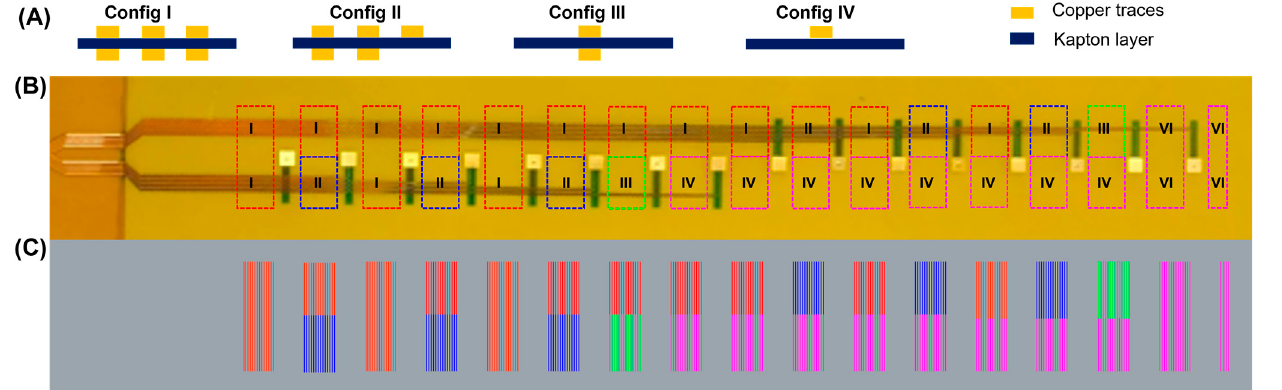
Figure 3. Schematic of various zones for dual-layer flex-PCB. ( A ) Schematics of four possible flex-PCB configurations: (I) multiple serpentines on both the top and bottom layers, (II) multiple serpentines on both top and bottom layers, plus a single layer serpentine on either layer, (III) single serpentine on both the top and bottom layers, and (VI) single serpentine on both either the top or bottom layer. ( B ) Image of dual-layer flex-PCB. ( C ) Image of laser cutting path with color-coded zones. Laser power values: (I) Red 11%, (II) Blue 8%, (III) Green 10%, and (IV) Magenta 8%. Laser speed: 20%.